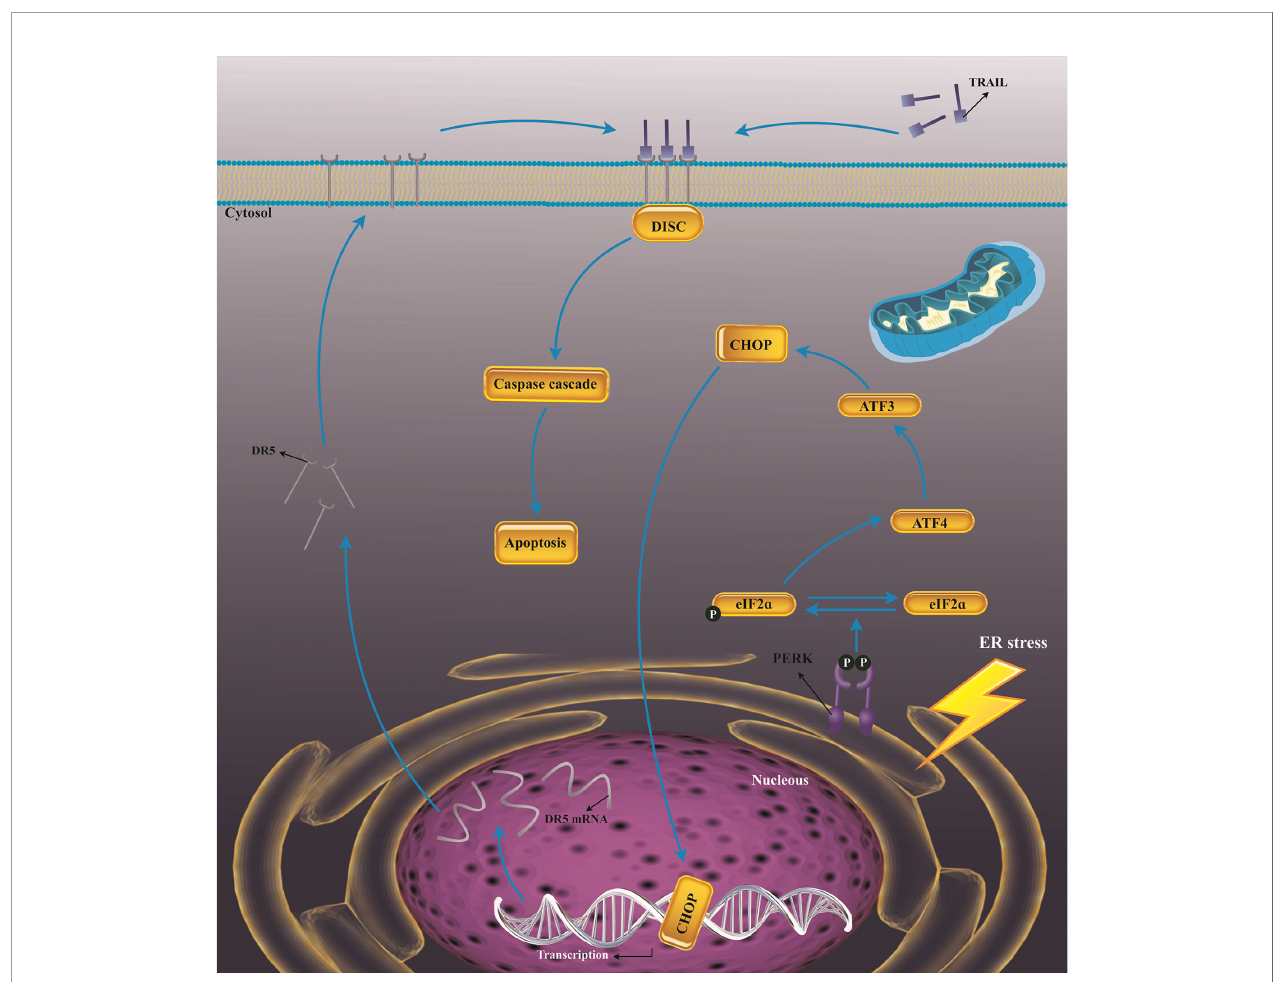
FIGURE 5 | The CHOP-mediated up-regulation of DR5. The ER stress stimulates the induction of PERK, which supports phosphorylation of eIF2 a , and thereby results in stimulation of translation of ATF4. Then, ATF4- ATF3- CHOP signaling pathway is elicited and contributes to the up-regulating DR5 expression, facilitating tumor cells-sensitivity to TRAIL. TRAIL, Tumor necrosis factor-related apoptosis-inducing ligand, CHOP, C/EBP homologous protein; PERK, Protein kinase R-like ER kinase; eIF2 a , Eukaryotic translation initiation factor 2 a ; ATF3/4, Activating transcription factor 3/4; ER Stress, Endoplasmic reticulum stress; DISC, Activation of death-inducing signaling